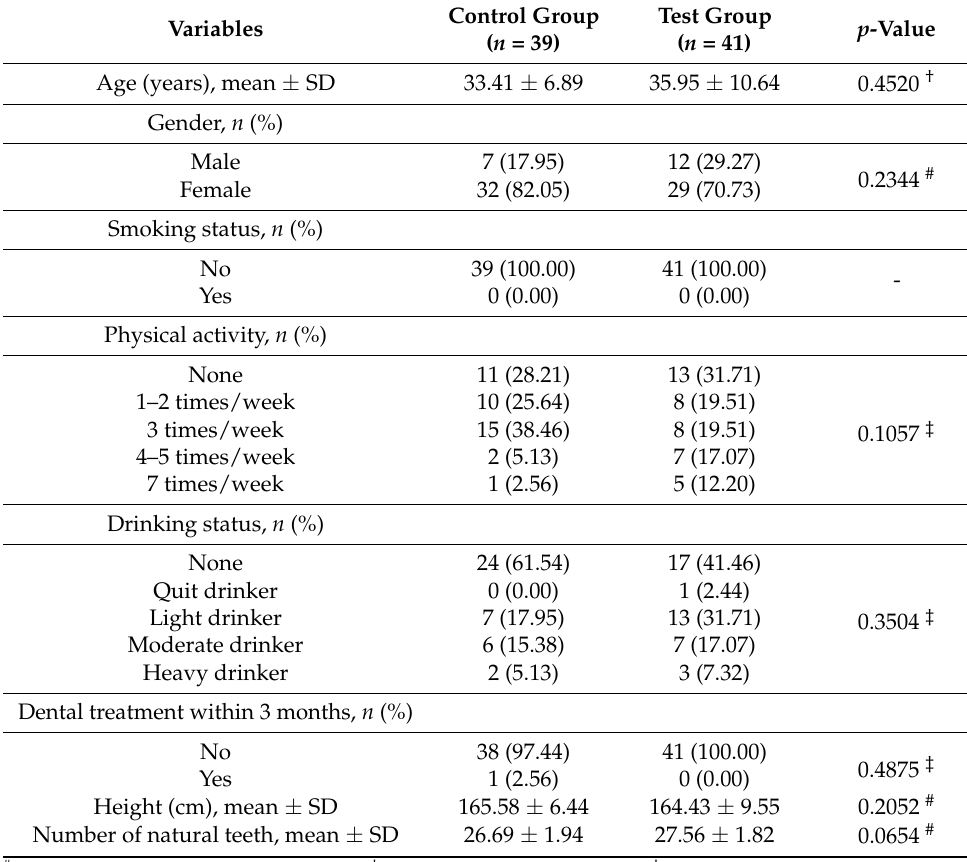
Table 2. Demographics and clinical characteristics of